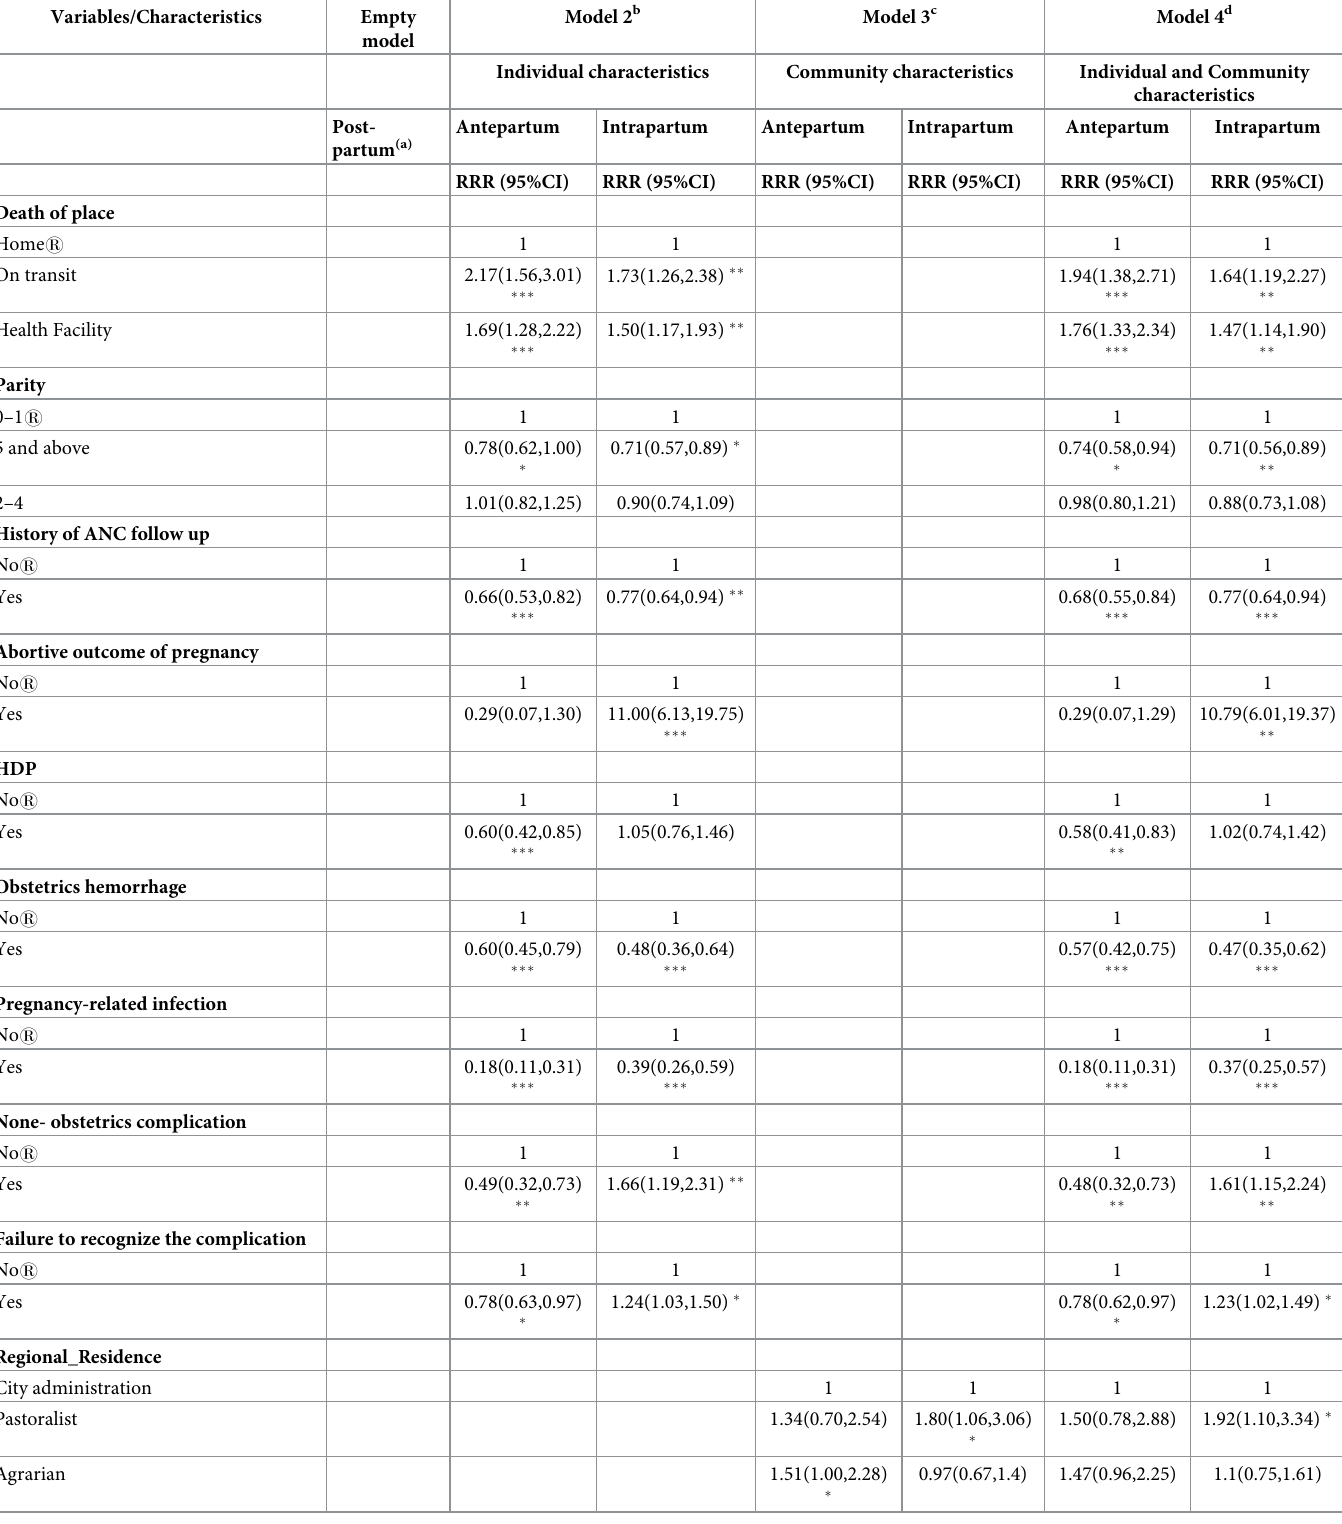
Table 5. Multilevel multinomial analysis of individual and community factors associated with the time of death among reviewed maternal death in Ethiopia,